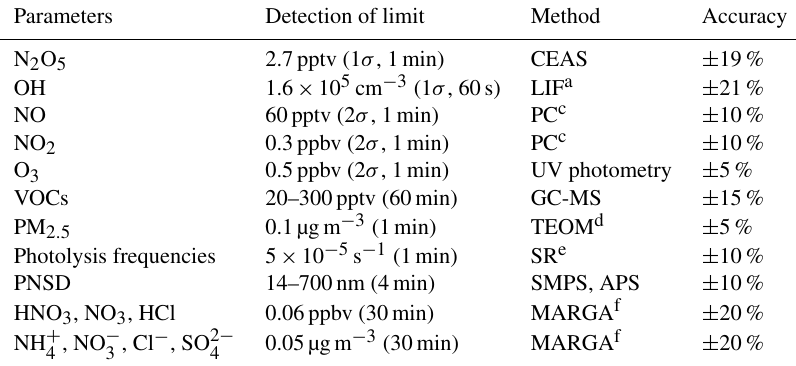
Table 1. The observed gas and particle parameters during the